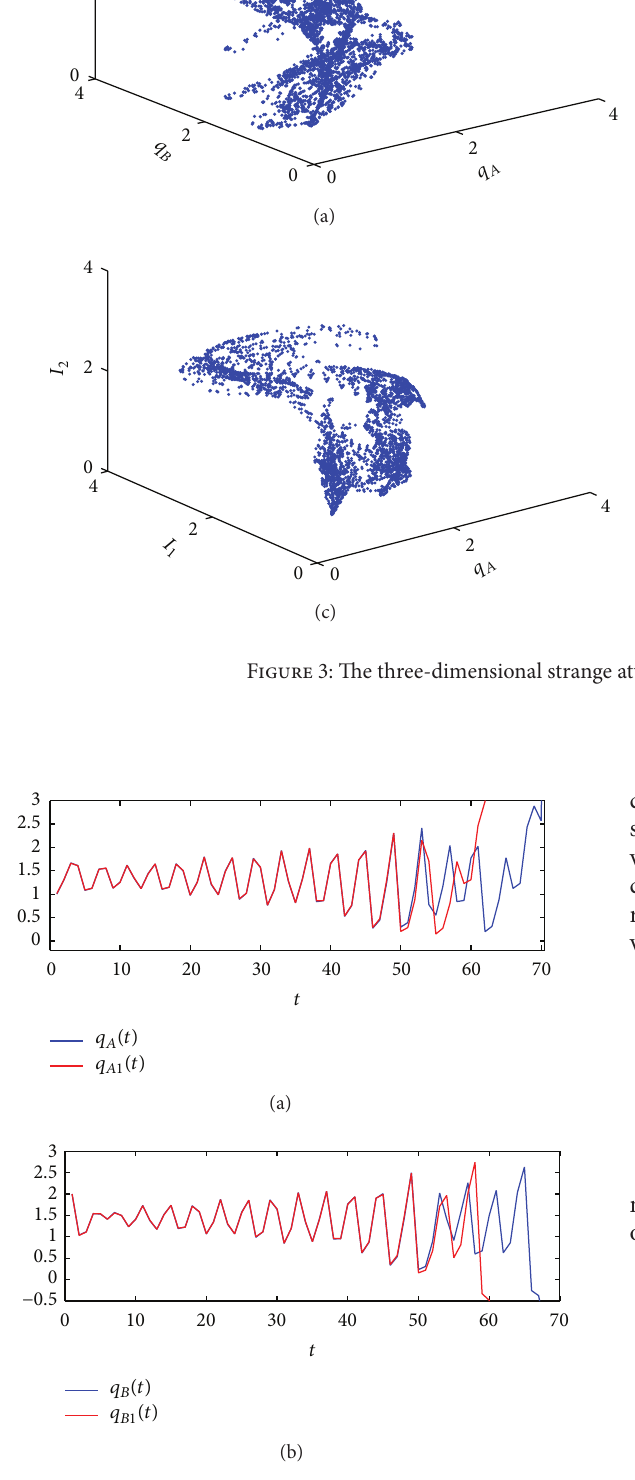
Figure 4: Sensitive dependence for the dynamical system (10) on initial conditions.